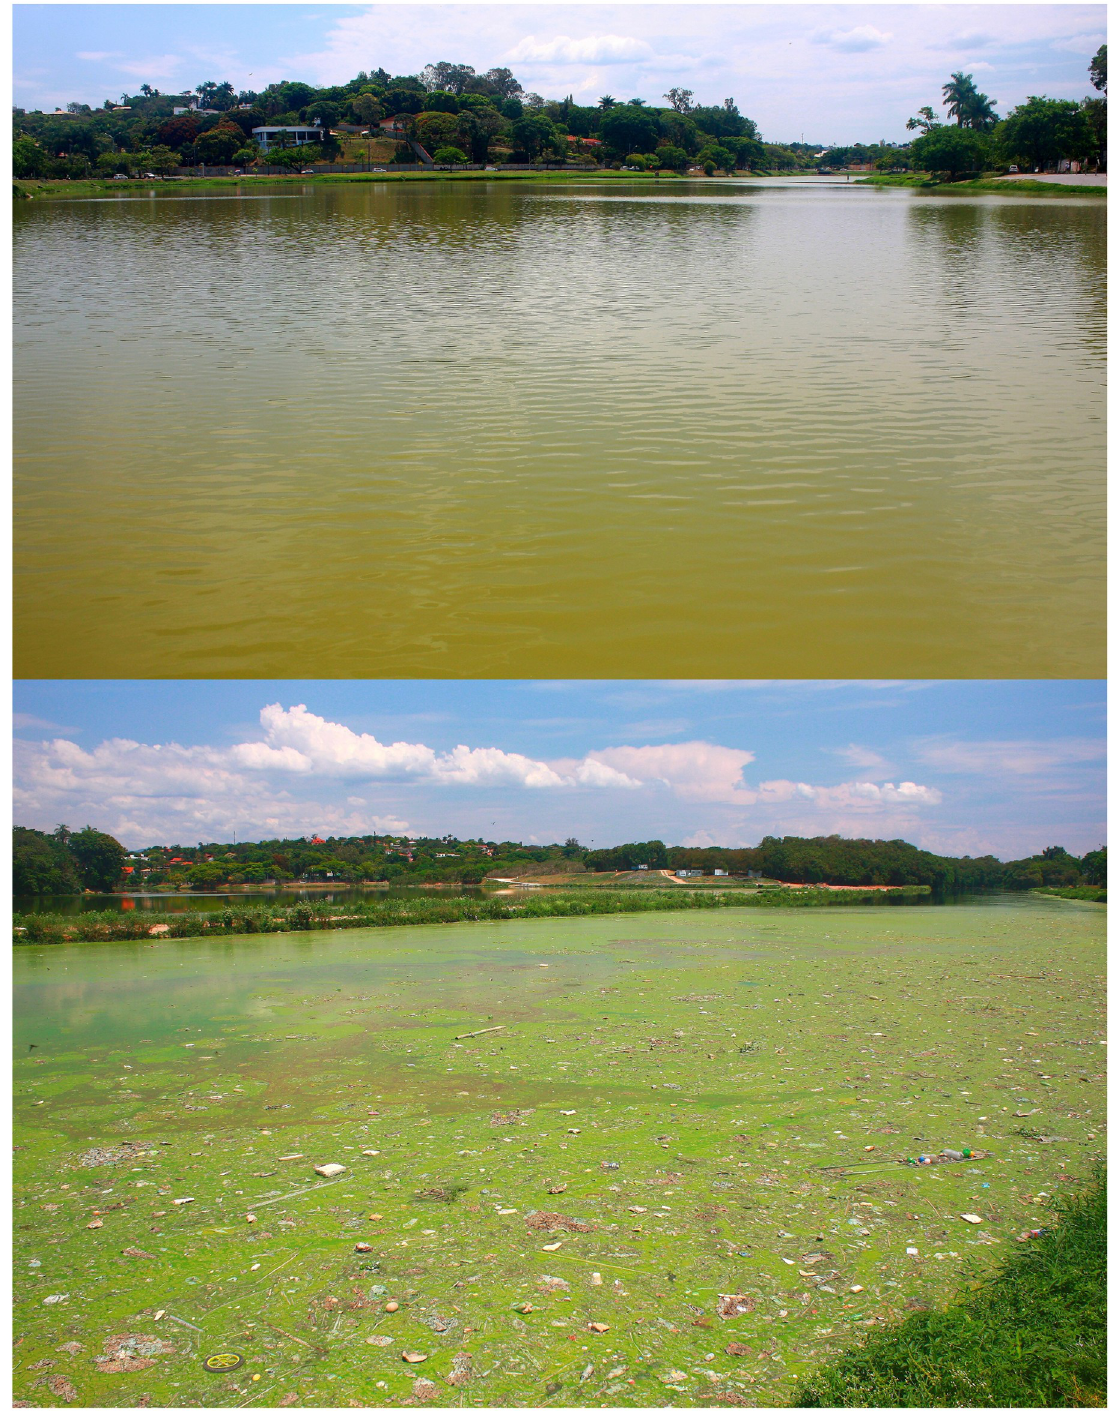
Fig 5. The Lagoa da Pampulha, at downtown of Belo Horizonte, Minas Gerais State, Brazil. The habitat of Hypostomus subcarinatus .